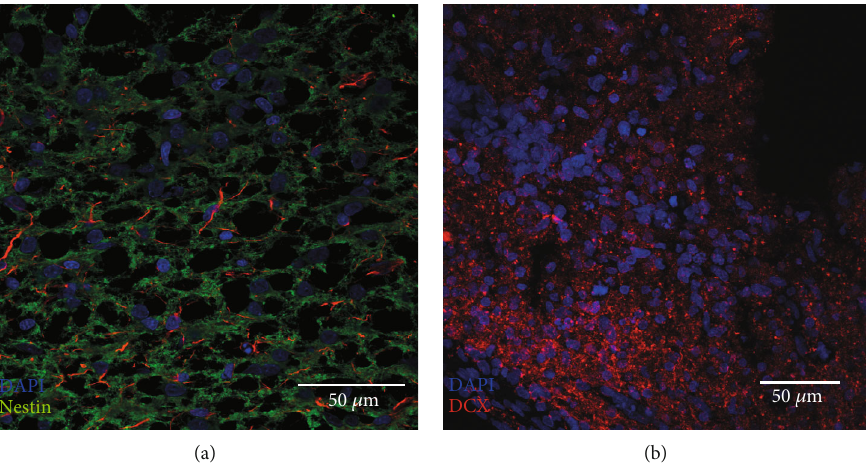
Figure 5: Tissue sections (20 μ m) of IC of PND6 rats with immunohistochemical staining of the progenitor cell markers Nestin (a) and doublecortin (DCX)